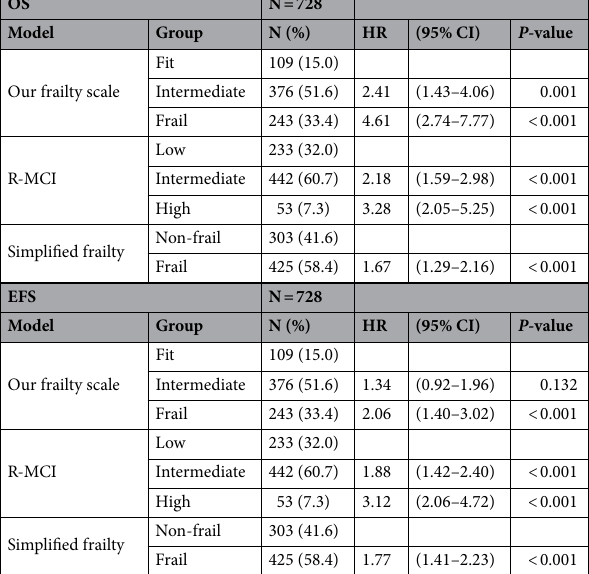
Table 4. Comparison of OS and EFS according to frailty models. OS , overall survival; EFS , event-free survival; HR ,,hazard ratio; 95% CI , 95% confidence interval; R-MCI , revised myeloma comorbidity index; simplified frailty , simplified frailty